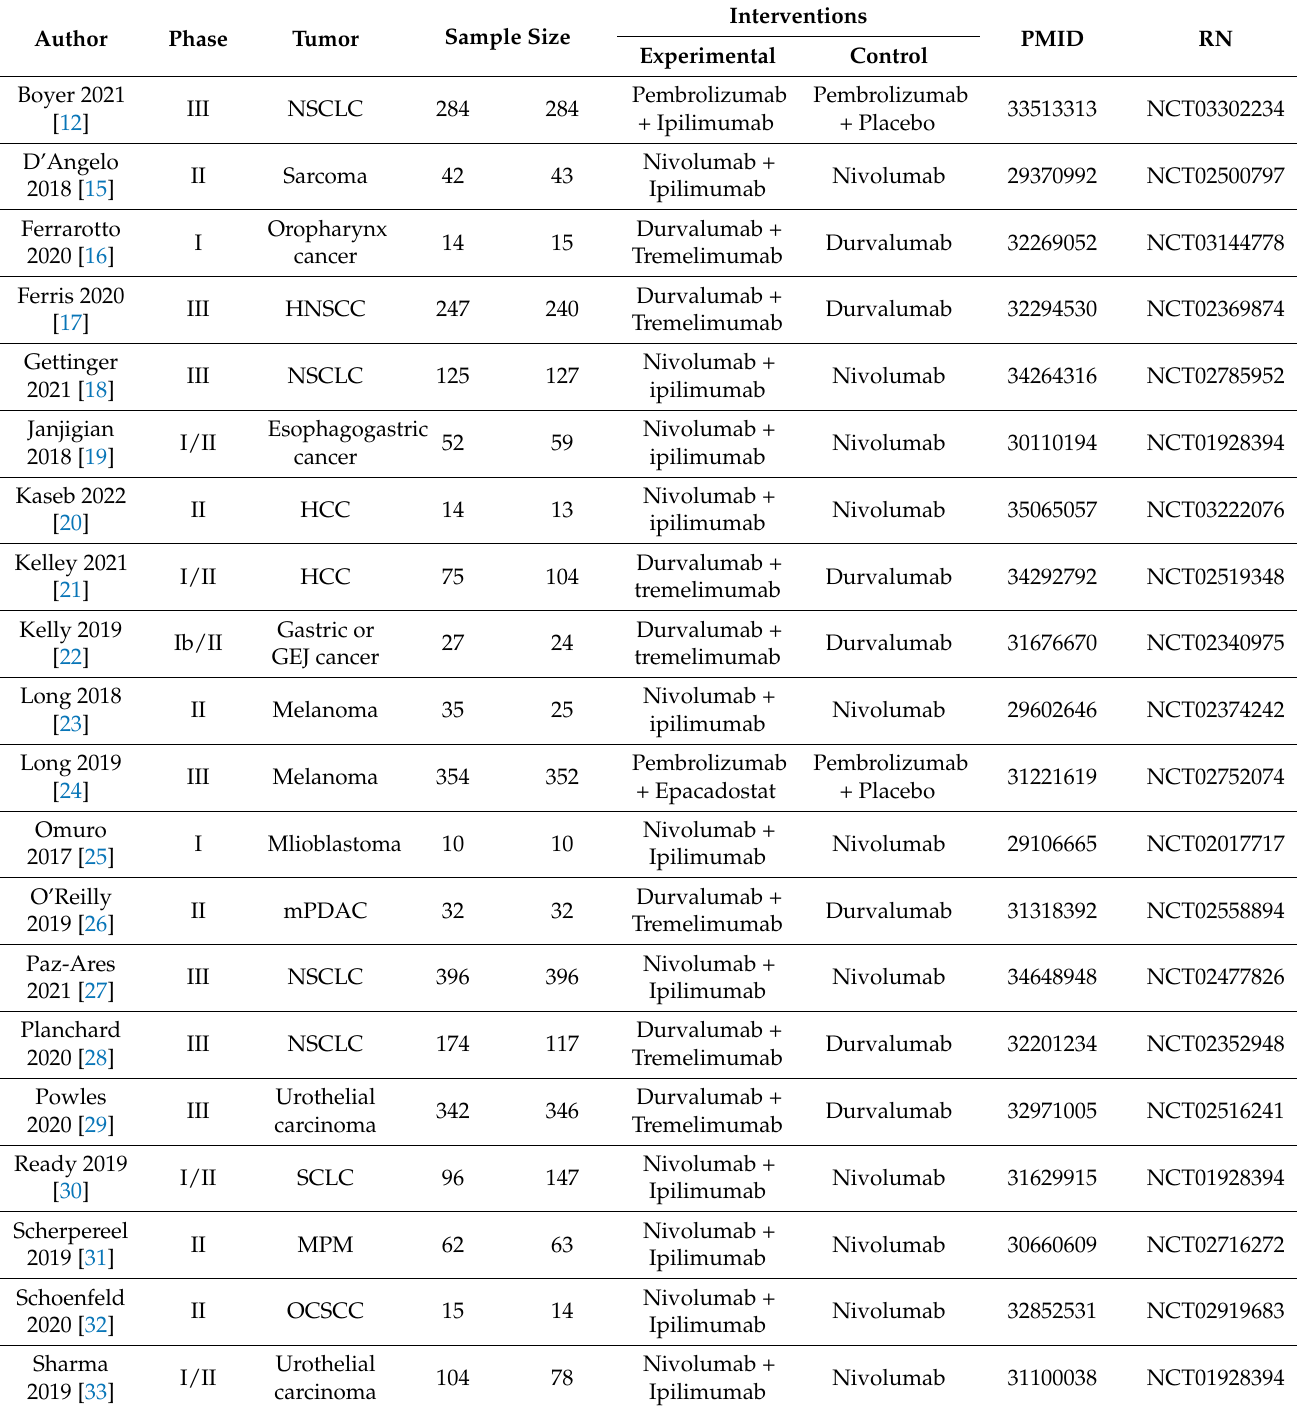
Table 1. Main characteristic of included